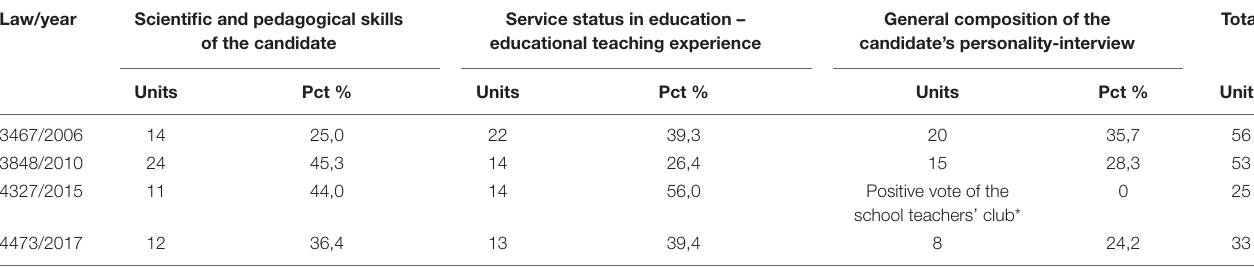
TABLE 1 | Changes in the weight of the general criteria for selecting school unit head teachers.